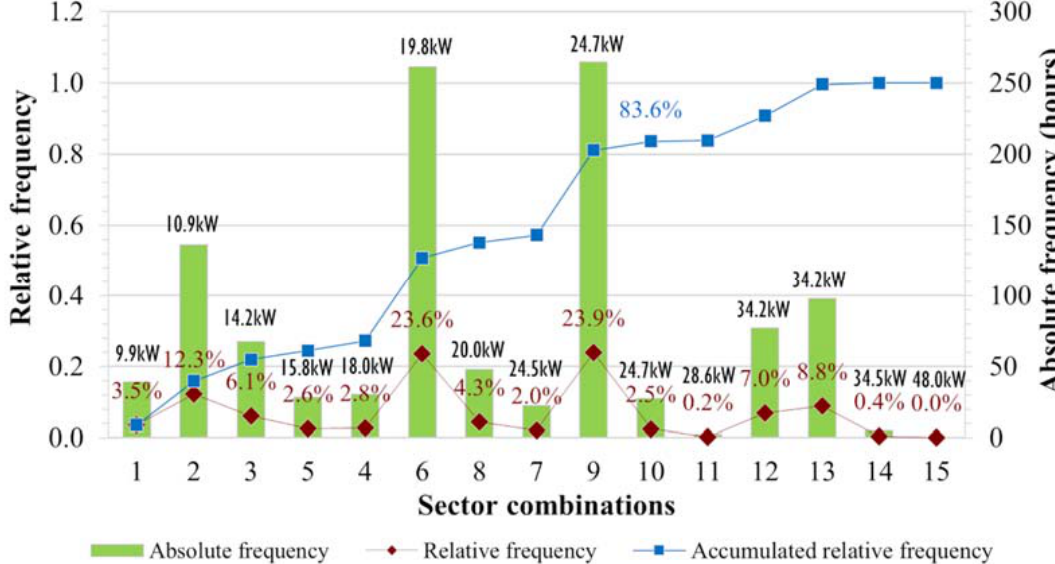
Figure 12. Frequency distribution of the combination of sectors of the daily work matrix simulation results for a configuration of 8 strings of 20 photovoltaic panels. Absolute frequency in hours. Combination of sectors C1 to C15 ordered from lowest to highest power required for operation. Green bars: operating hours for each combination of sectors. Label on bar: minimum electrical power required for the operation of the combination of sectors.